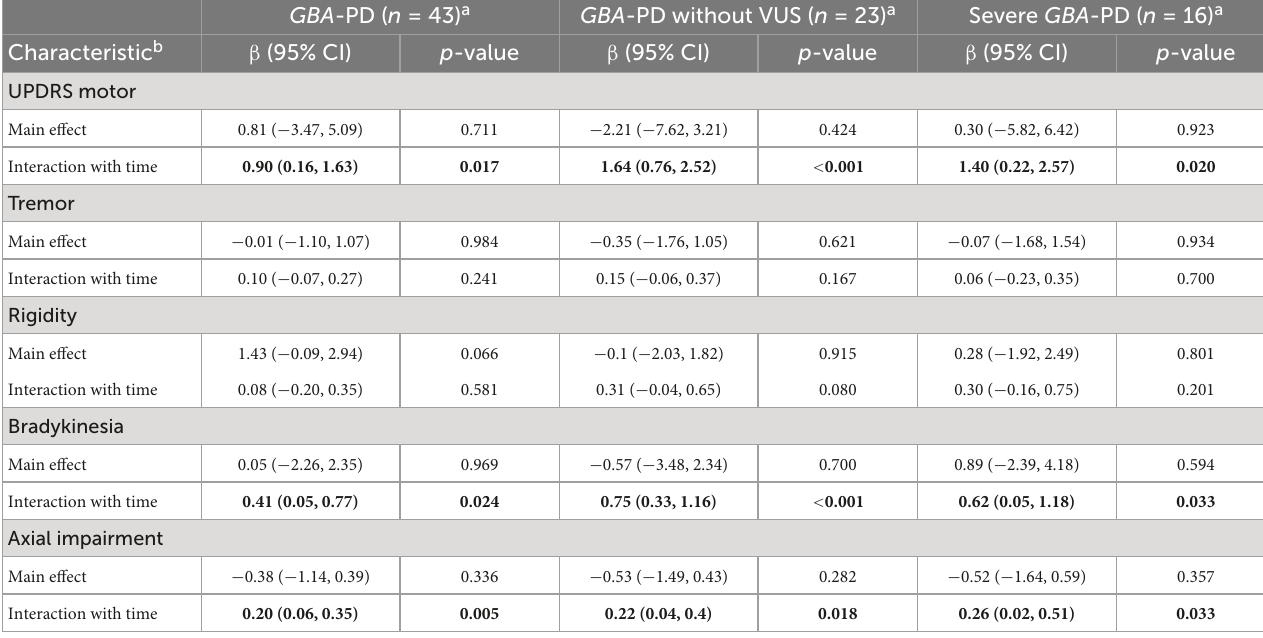
TABLE 2 Association between GBA carrier status and annual change in Unified Parkinson’s Disease Rating Scale (UPDRS) motor scores and subscores using linear mixed-effects models. GBA -PD ( n = 43) a GBA -PD without VUS ( n = 23) a Severe GBA -PD ( n = 16) a Characteristic